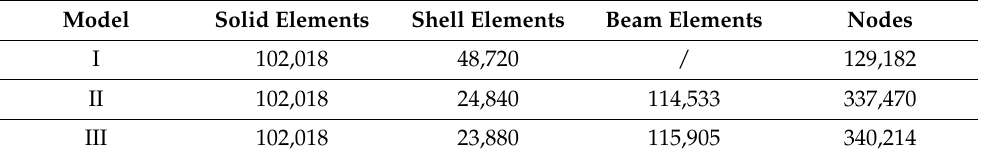
Figure 5. Crash zone of fuselage and wing. Table 1. Total number of elements and